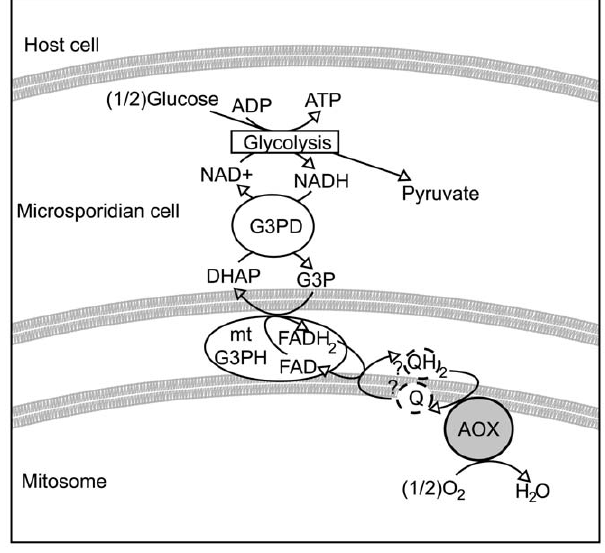
Figure 5. Hypothetical scheme of function of the alternative oxidase in the microsporidian cell. Microsporidian cells are known to contain glycolytic enzymes, though no obvious mechanism exists for reoxidising NADH to NAD + . The glycerol-3-phosphate shuttle is encoded in many microsporidian genomes. If this shuttle is coupled to an alternative oxidase protein in the mitosome, it could potentially represent a mechanism for regenerating NAD + .